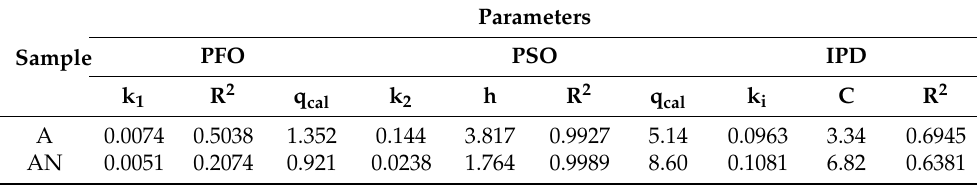
Table 4. Kinetic parameters for simultaneous Cu 2+ and Zn 2+ adsorption on the activated carbons C init = 10 mg/L.